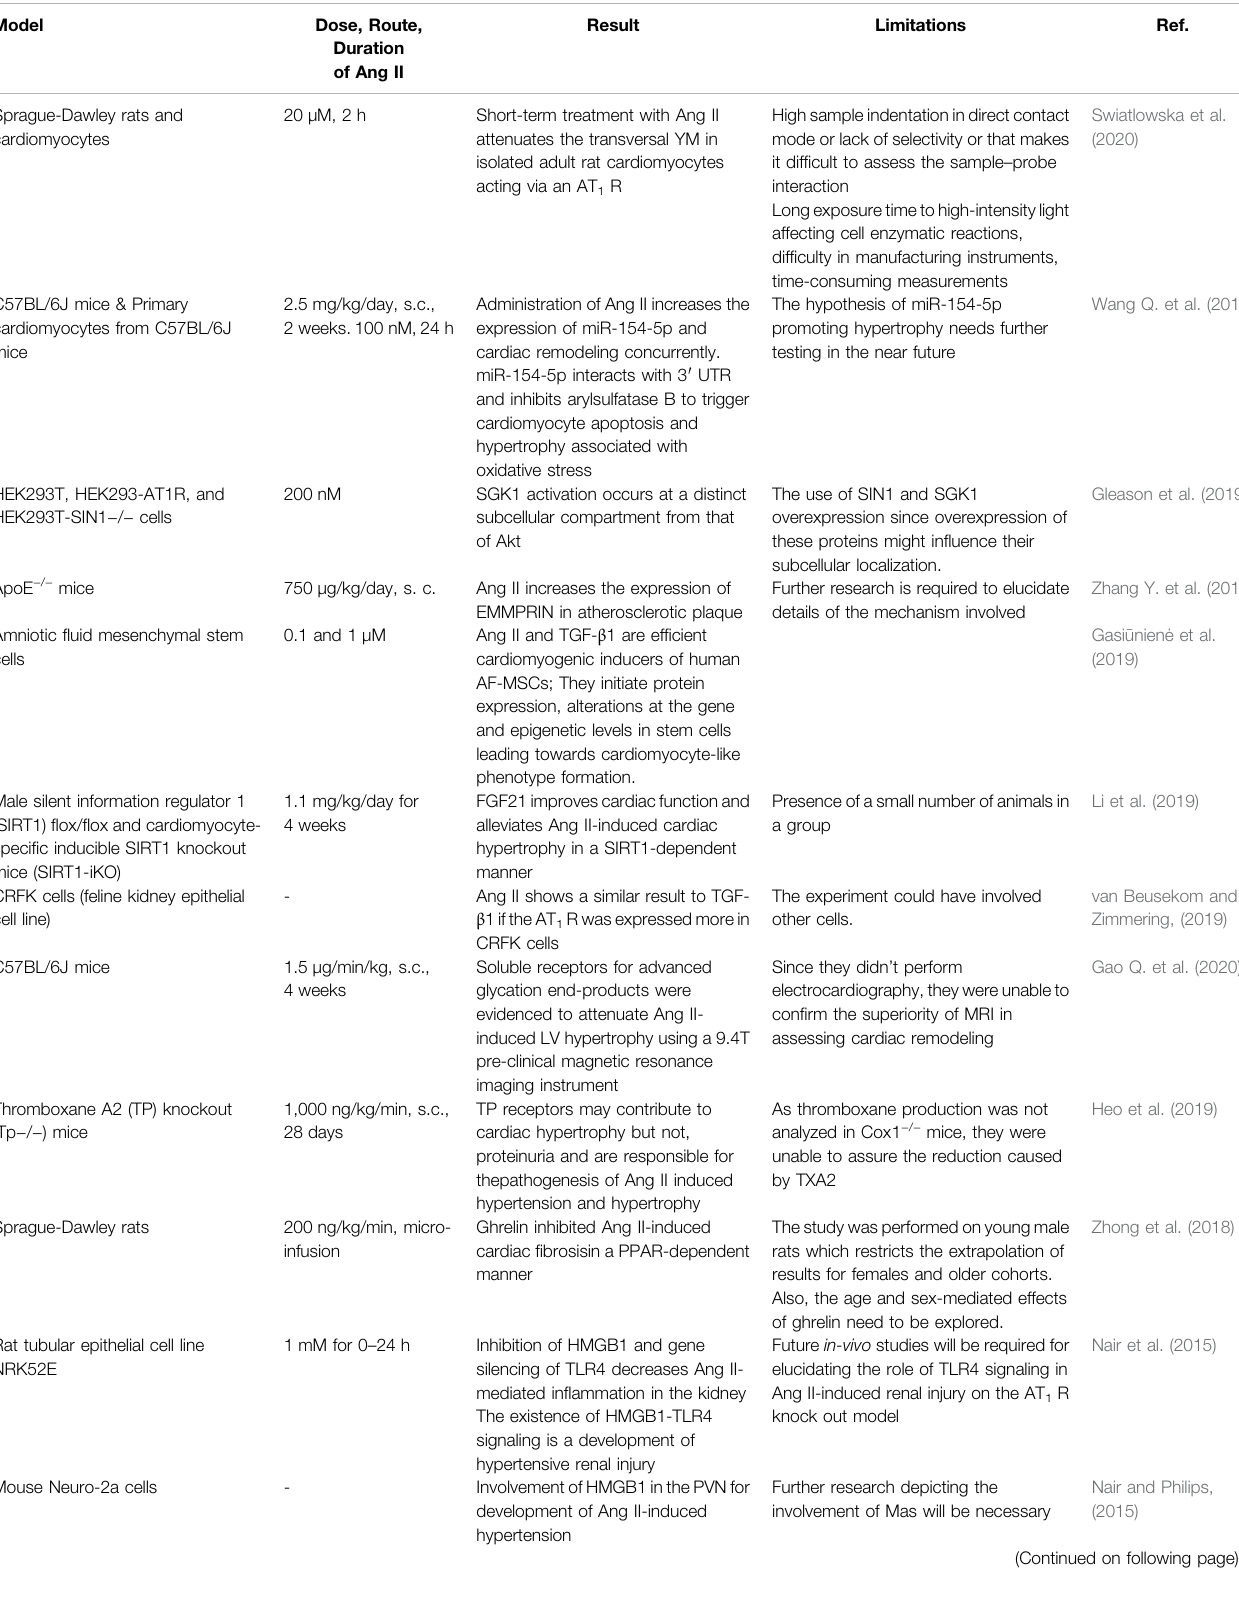
TABLE 3 | Studies of effect of angiotensin II in in-vivo and in-vitro studies.